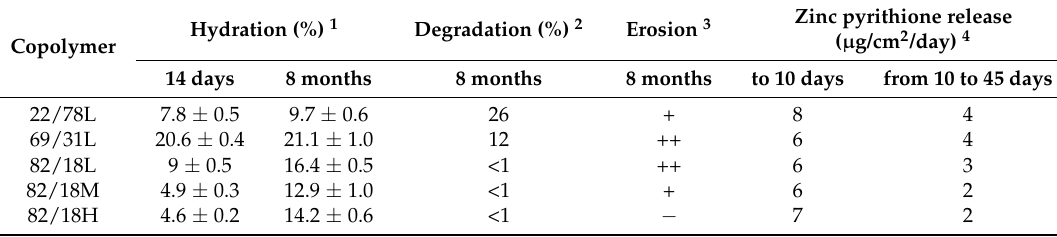
Table 4. Hydration, degradation and erosion of copolymers in paints during immersion.